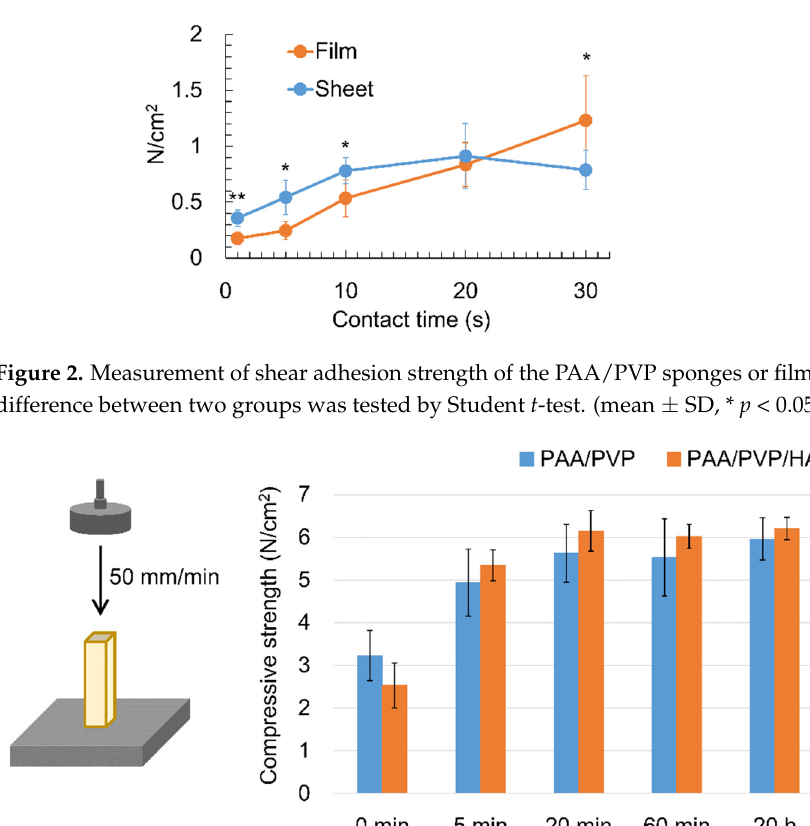
Figure 3. Compressive strength of PAA/PVP complexes prepared with or without HA freeze-dried after various swelling time. Data are presented as mean (SD).